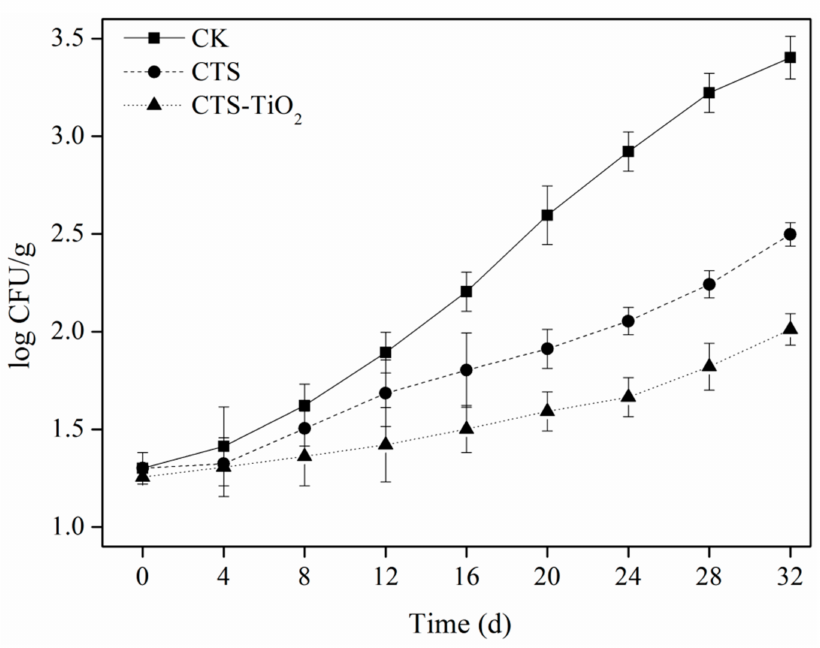
Figure 5. Effects of different treatments on contents aerobic mesophilic bacteria of blueberry fruit during 32 days of storage at 0 ◦